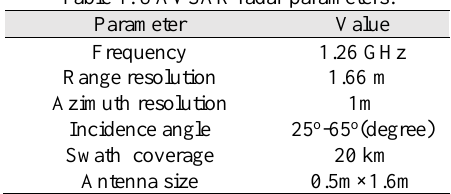
Figure1. Pauli images of datasets, (a)data 1 in 2009, (b) data 1 in 2015, (c)ground truth of data 1 , (d) data 2 in 2009, (e) data 2 in 2015, and (f) ground truth of data 2 . Table 1. UAVSAR radar parameters.